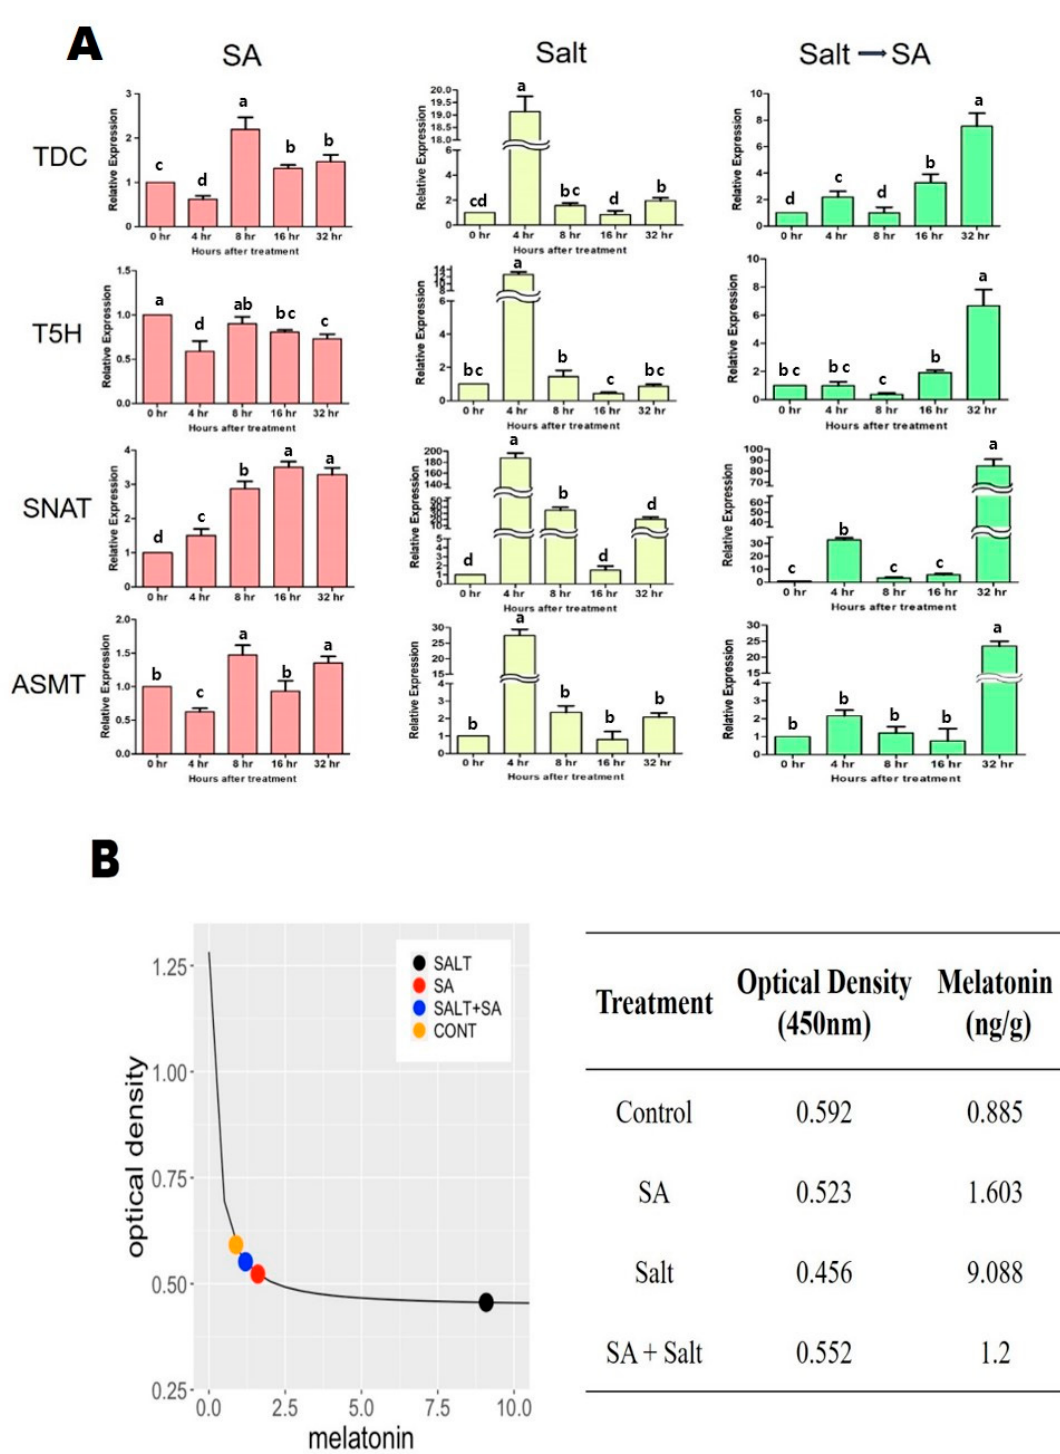
Figure 7. Impact of salicylic acid application on ( A ) endogenous melatonin content and ( B ) relative expression of genes ( TDC , T5H , SNAT and ASMT ) associated with melatonin synthesis in salinity- damaged St. John’s leaves. Treatments: control, SA (0.25 mM salicylic acid), salt (150 mM NaCl), SA (0.25 mM salicylic acid) + salt (150 mM NaCl). Each value represents the mean ± SD ( n = 3). In all data, error bars represent standard deviations and each data point represents the mean of at least three replications. Different letters on each bar represent statistically significant differences as evaluated by DMRT and t -test at p ≤